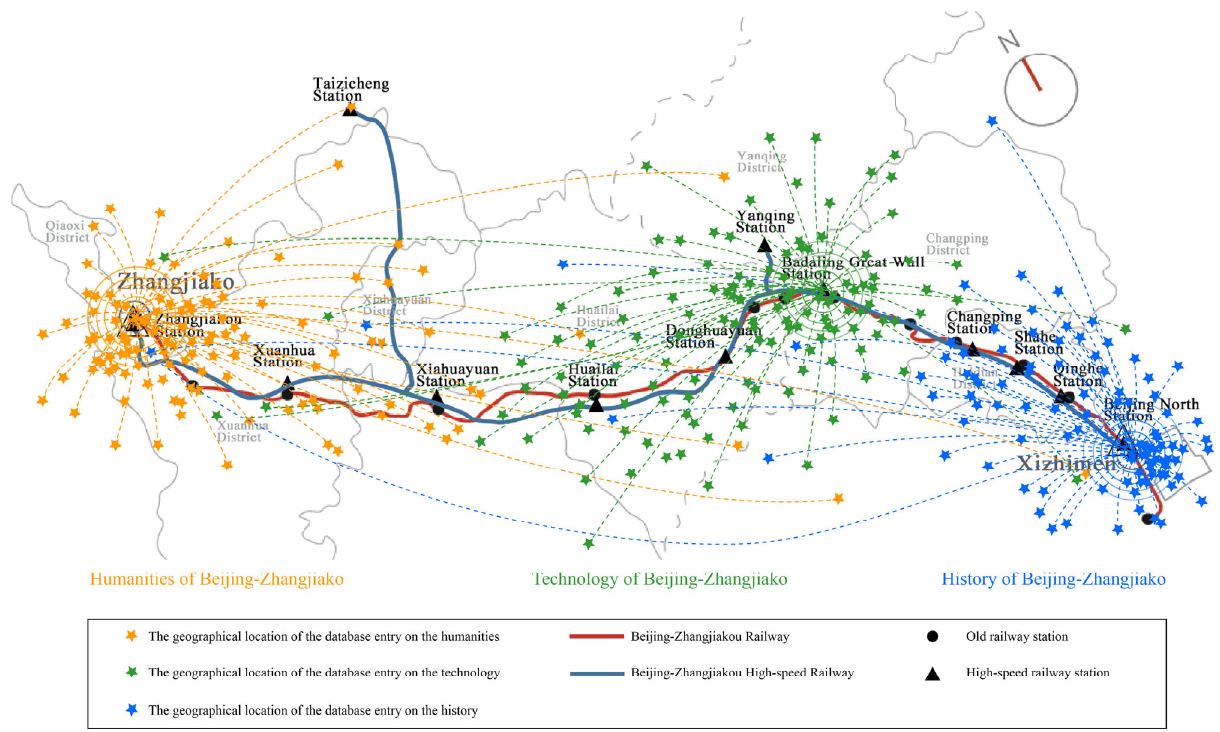
Figure 1. Cultural theme segmentation for the Beijing–Zhangjiakou high ‐ speed railway.